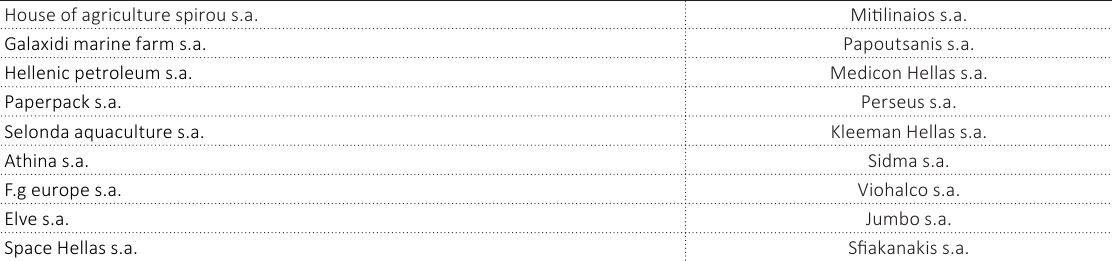
Table A1. Greek examined listed firms with a merger decision House of agriculture spirou